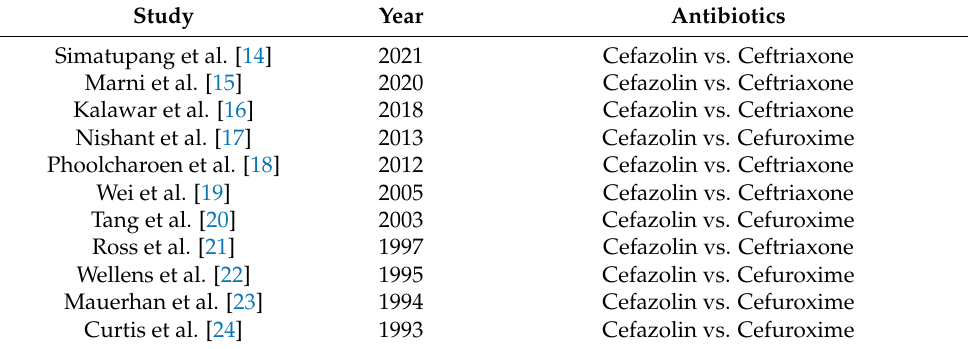
Figure 1. Study Flow Chart. Table 1. The studies that were included in the